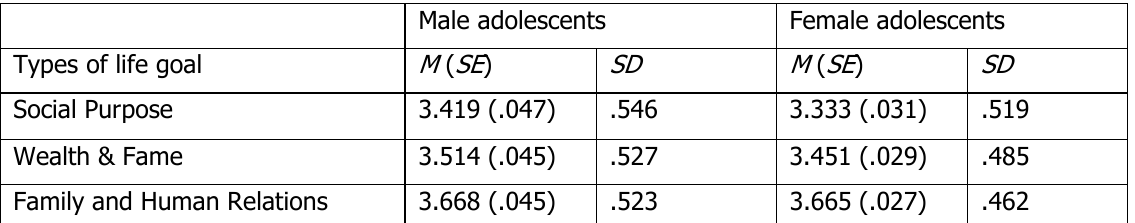
Descriptive statistics of the life goals for male and female participants (n = 412)